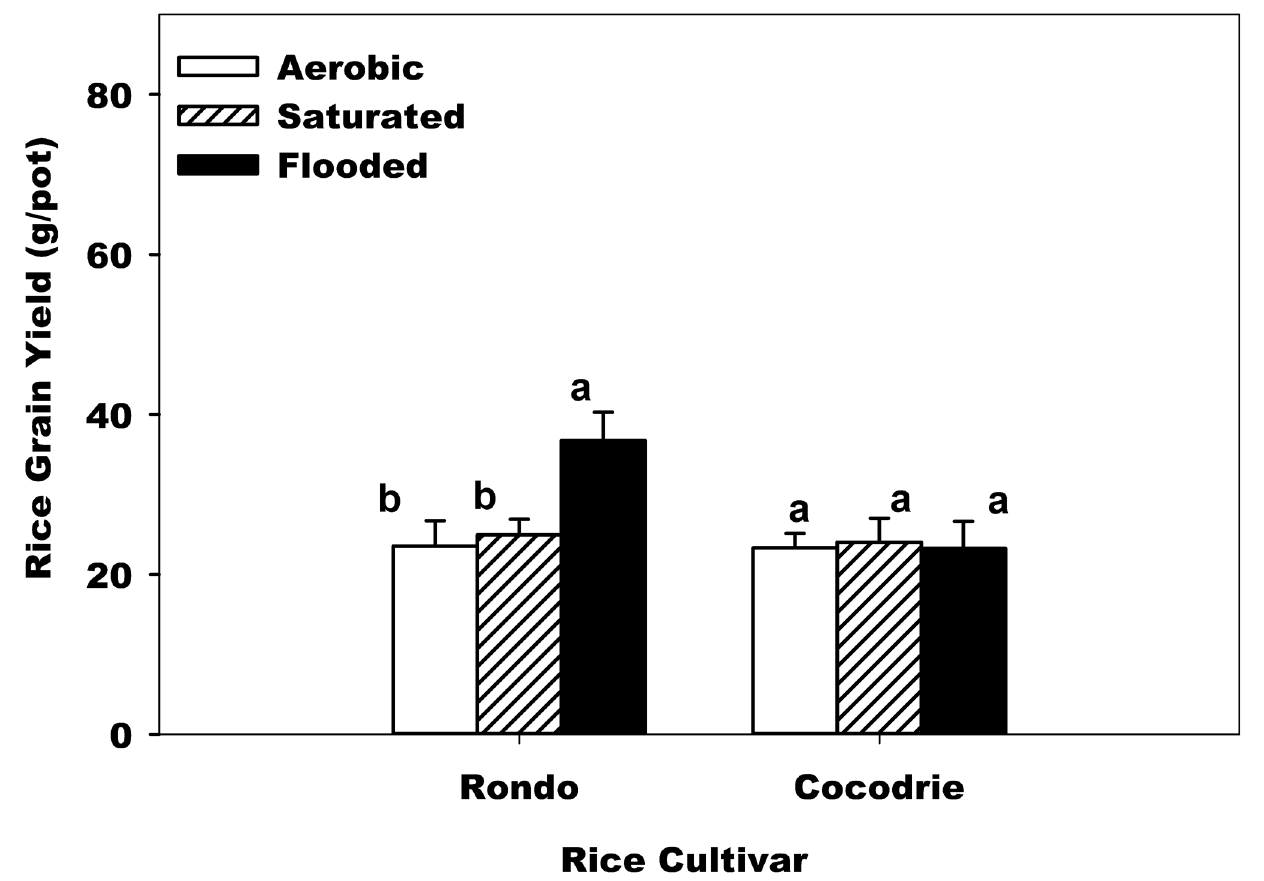
Fig 1. Effect of water regime and cultivar across soil texture on rough rice grain yield (g/pot). Error bars denote the standard error of the mean. Bars with the same letters above are not significantly different based on Fisher ’ s protected LSD ( P = 0.05) within the cultivar.